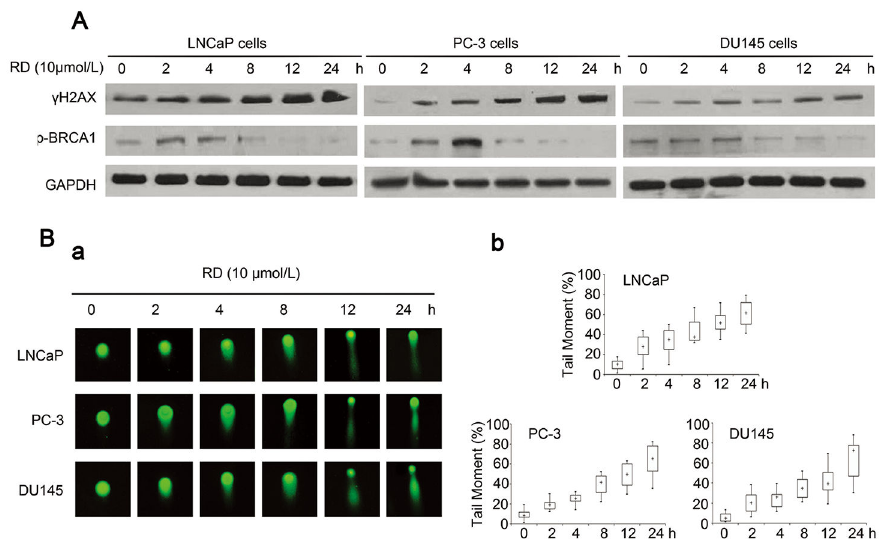
Figure 2. RD induced DSBs in PCa cells. A , Immunoblot analysis of expression levels of p-BRCA1, and γH2AX in LNCaP, PC-3, and DU145 cells exposed to RD, respectively. B , a , Neutral comet assay was performed to determine DNA fragment in RD-treated cells. b , Distribution of mean comet length (100 cells per sample) was calculated by box and whisker plot. Medians are indicated by cross; interquartile range (25-75%; IQRs) are indicated by open boxes. The whiskers are 1.5 times the IQR distribution. doi: